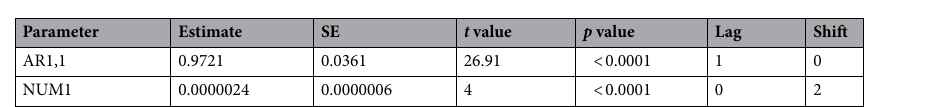
Figure 2. Time-series plot of ESBL-producing E. coli proportion and AUD from 1 January 2012 to 30 June 2019. AUD of ( A ) ciprofloxacin, ( B ) cefepime, ( C ) piperacillin-tazobactam and ( D ) third-generation cephalosporin.